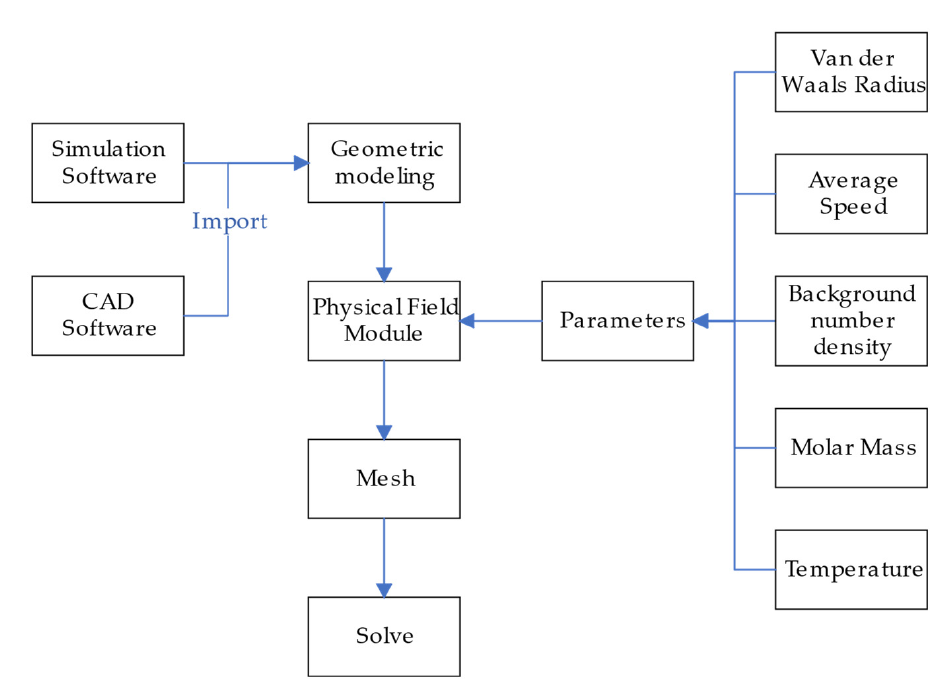
Figure 4. Flowchart of building